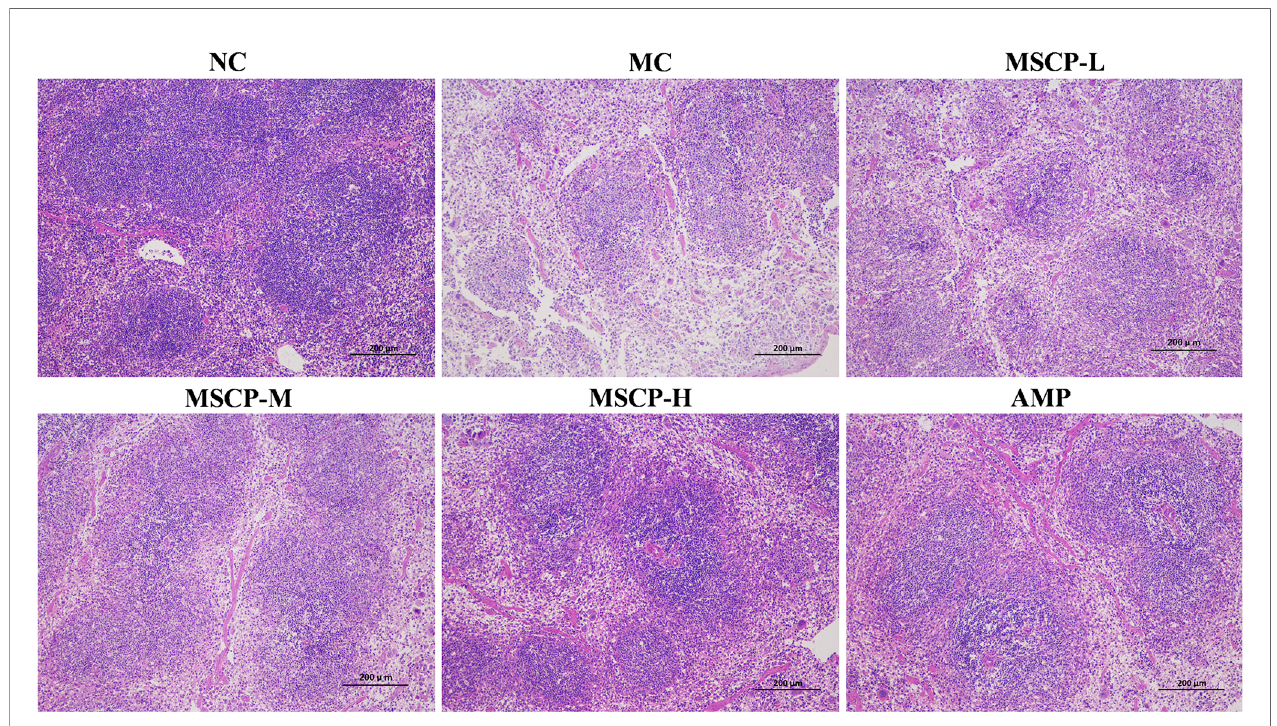
FIGURE 6 | Effects of MSCP on the spleen tissues shown in HE-stained histopathological images. (100 ×, Scale bar = 200 mm).